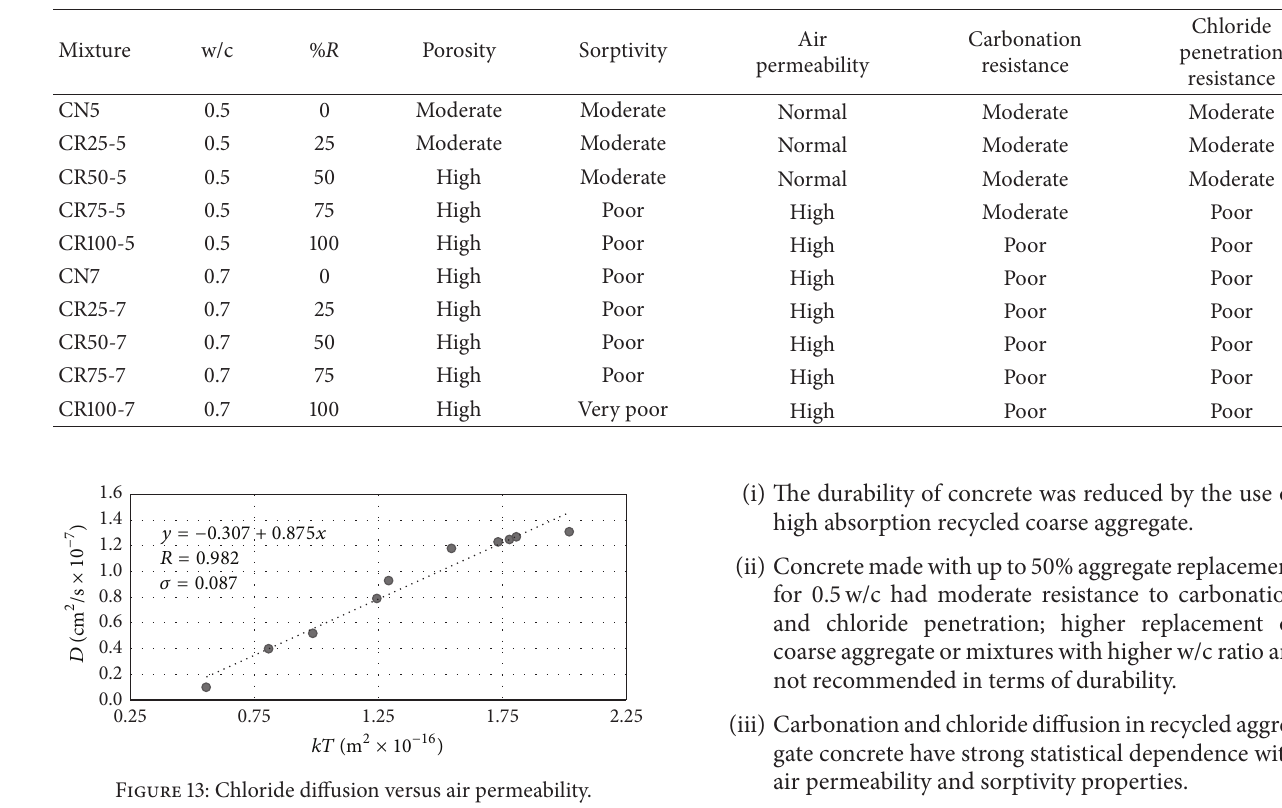
Table 6: Durability indicators in recycled aggregate concrete.